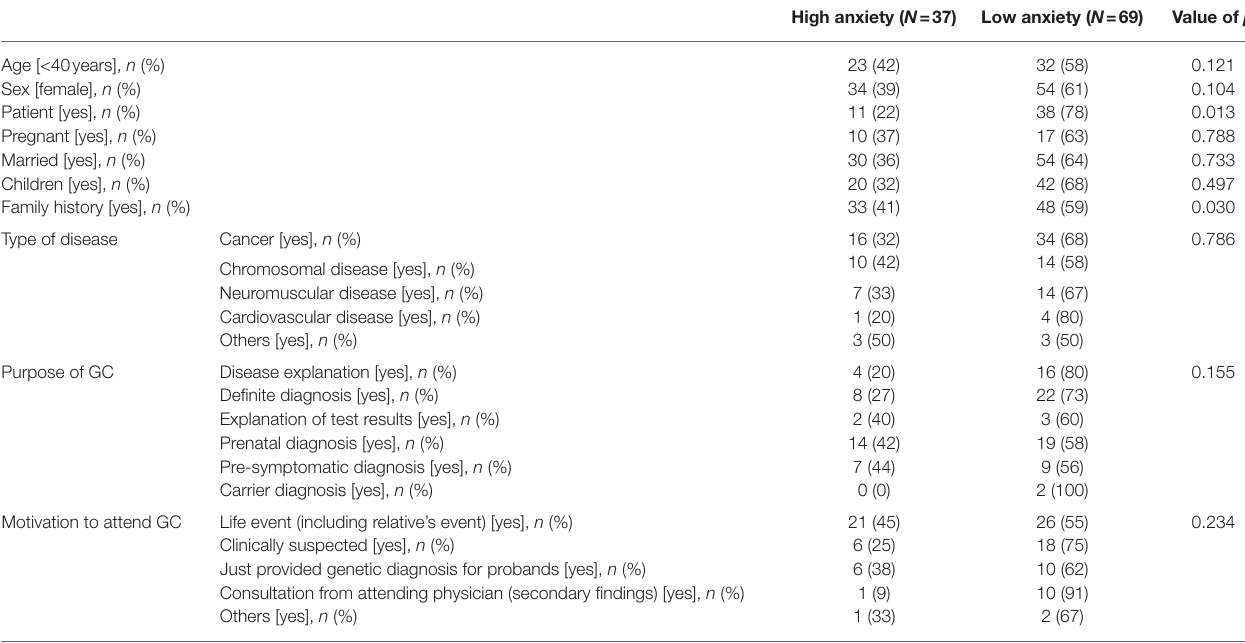
TABLE 4 | State anxiety by the characteristics of GC clients.